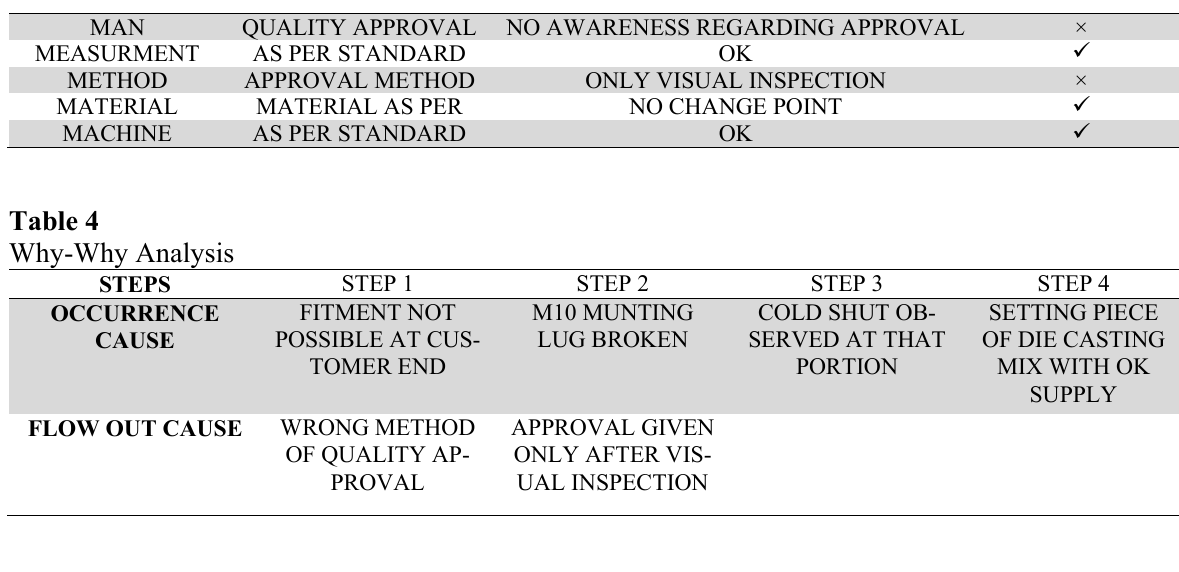
5-M Analysis 5M SPECIFICATION ACTUAL JUDGEMENT MAN QUALITY APPROVAL NO AWARENESS REGARDING APPROVAL MEASURMENT AS PER STANDARD METHOD APPROVAL METHOD ONLY VISUAL INSPECTION MATERIAL MATERIAL AS PER MACHINE 